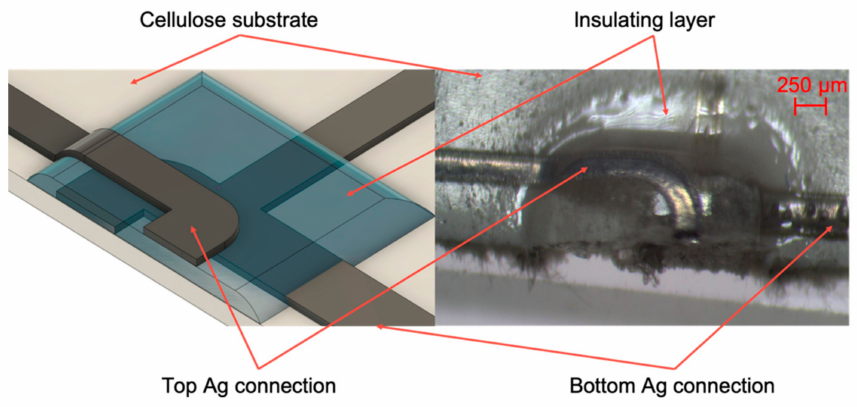
Figure 5. Microscope magnification of a multilayer